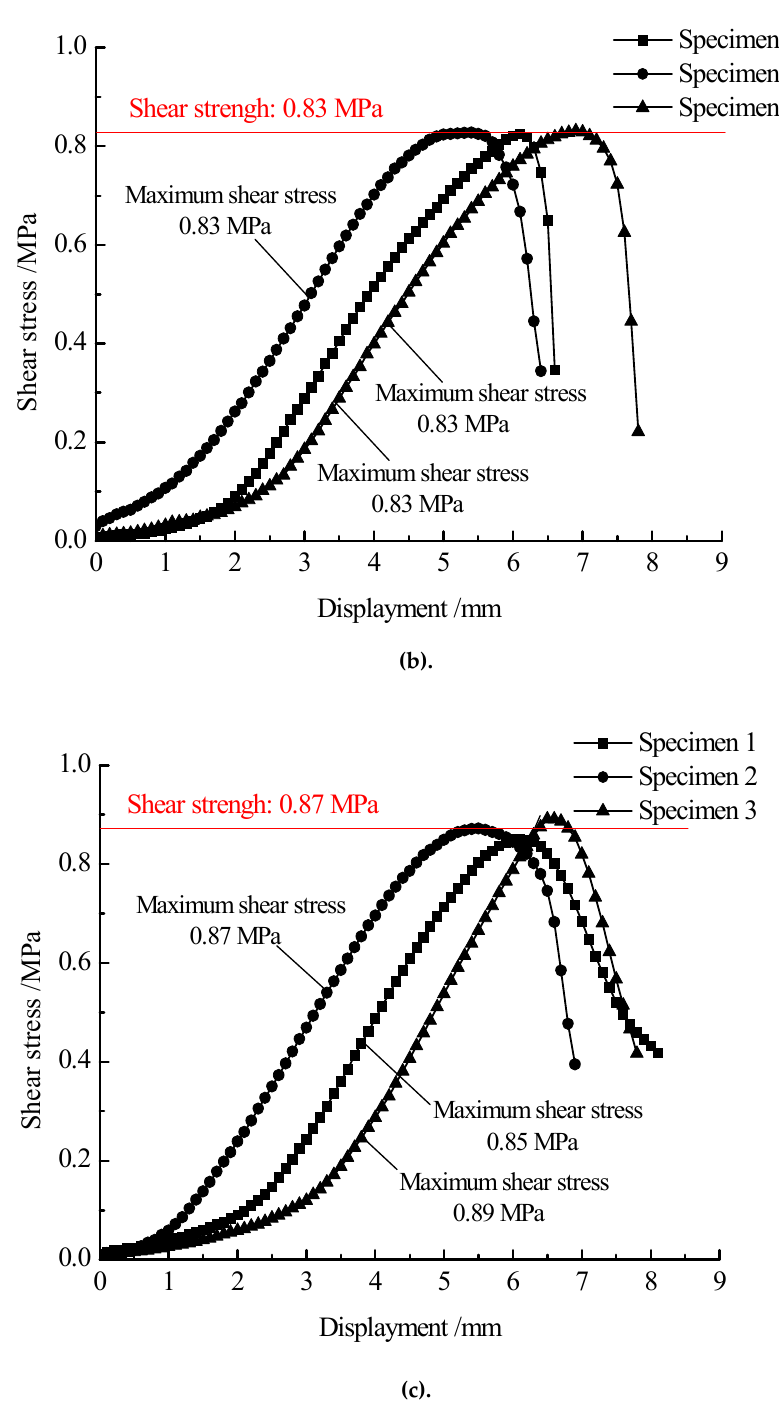
Stress-strain relationship of specimens compacted at di ff erent temperatures by the Figure 7. Stress ‐ strain relationship of specimens compacted at different temperatures by the double ‐ 260 double-decked method: ( a ) 120 ◦ C; ( b ) 140 ◦ C; ( c ) 160 ◦ decked method: ( a ) 120 °C; ( b ) 140 °C; ( c ) 160 °C. 261